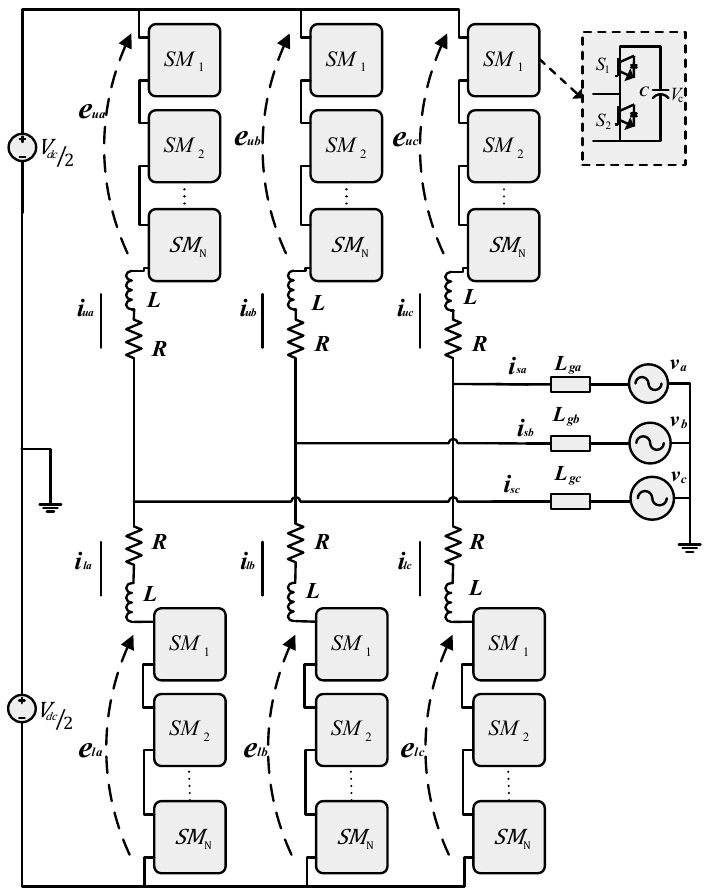
Figure 1. 3 Phase circuit diagram of modular multilevel converter (MMC) .